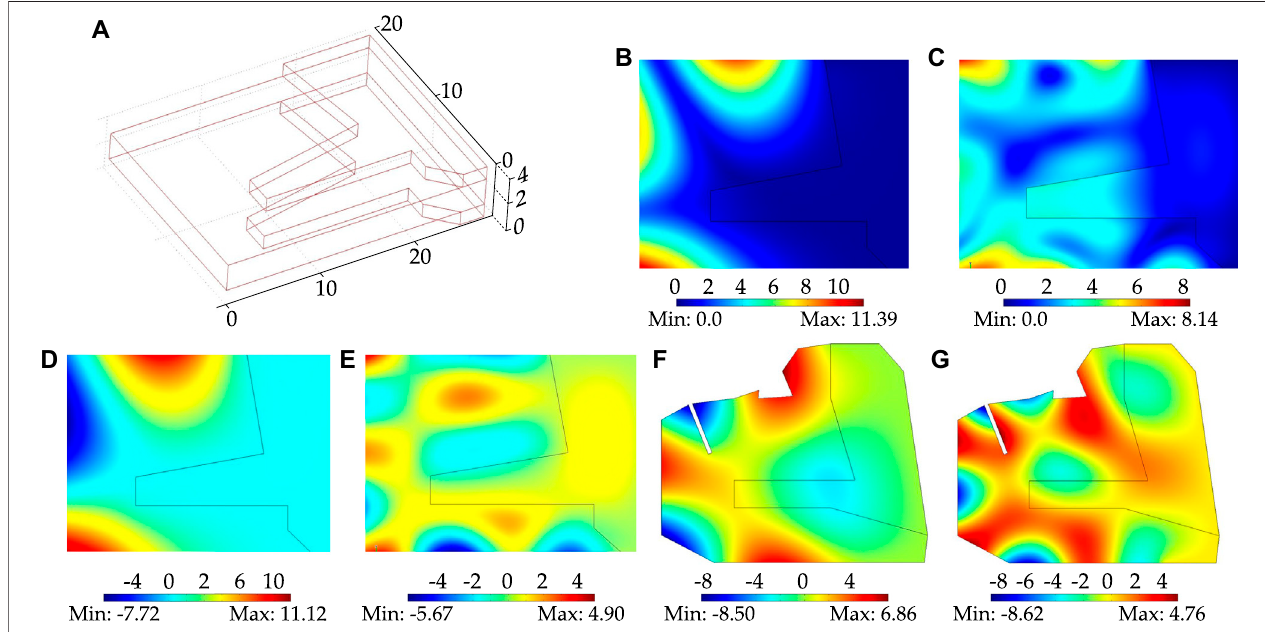
FIGURE 4 | Vibrations pattern obtained via numerical simulations of a fi nite elastic solid having variable thickness. The thickness of the solid is comparable to the variable depth of the sedimentary cover commensurate with the geoblock that accommodates the test seismic region. (A) details of the shape and the thickness pro fi le used in the simulations and chosen according to the geophysical data; 3D simulation of the dynamics of a solid of variable thickness in the rectangular computational window; (B-E) — 3D simulation of the dynamics of a solid of variable thickness in the rectangular computational window, (B – C) — modulus of the longitudinal displacement, (D – E) the vertical displacement; (F,G) Mindlin plate approximation, withtheaccurate morphologyofthegeoblock,the map ofthevertical displacementis shownfortheseeigenmodes.Illustrationsaregivenfor: (B-E) alowfrequencyvibration(modeNo.3,at0.32Hz), (C-D)